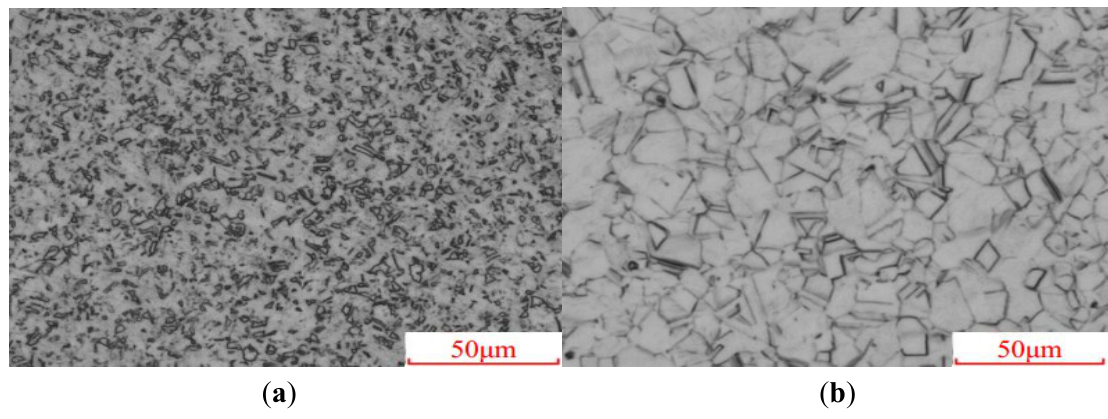
Figure 1. Optical micrographs of Cu-0.4wt%Mg alloy by Conform-process ( a ) and subsequent cold drawing ( b ) for contact wire products.